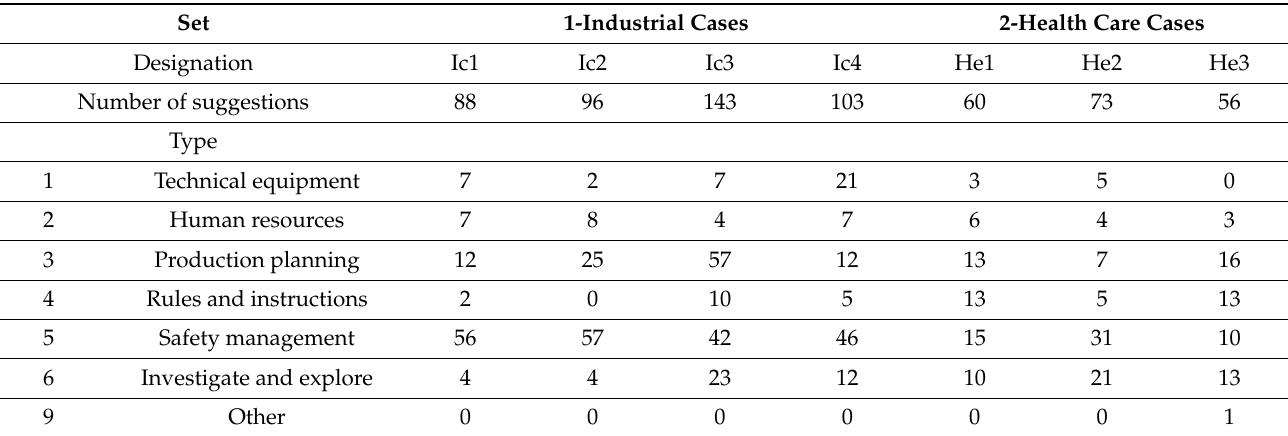
Table 5. Distribution of types of reforms from the combined method